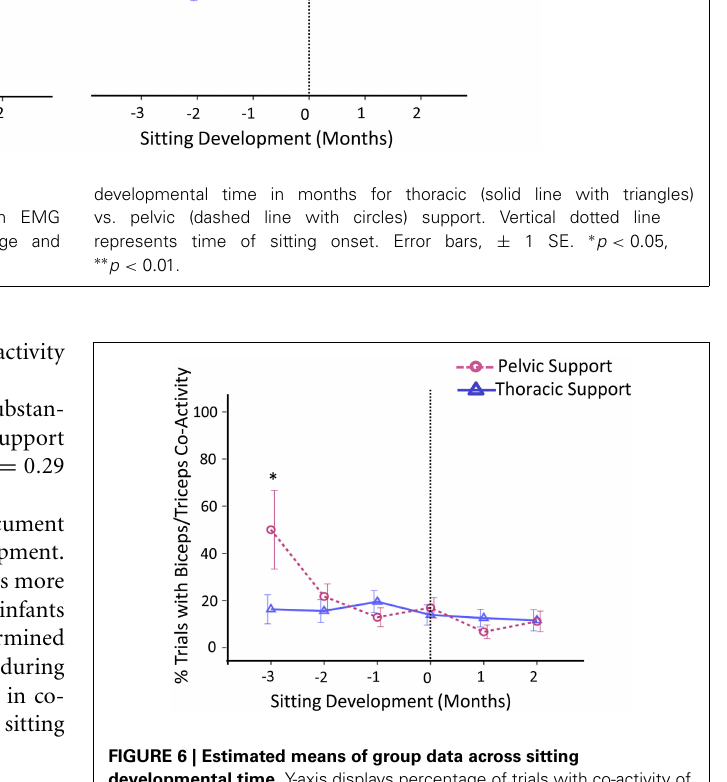
FIGURE 6 | Estimated means of group data across sitting developmental time. Y-axis displays percentage of trials with co-activity of biceps and triceps muscles. X-axis displays developmental time in months for thoracic (solid line with triangles) vs. pelvic (dashed line with circles) support. Vertical dotted line represents time of sitting onset. Error bars, ± 1 SE. ∗ p < 0 .